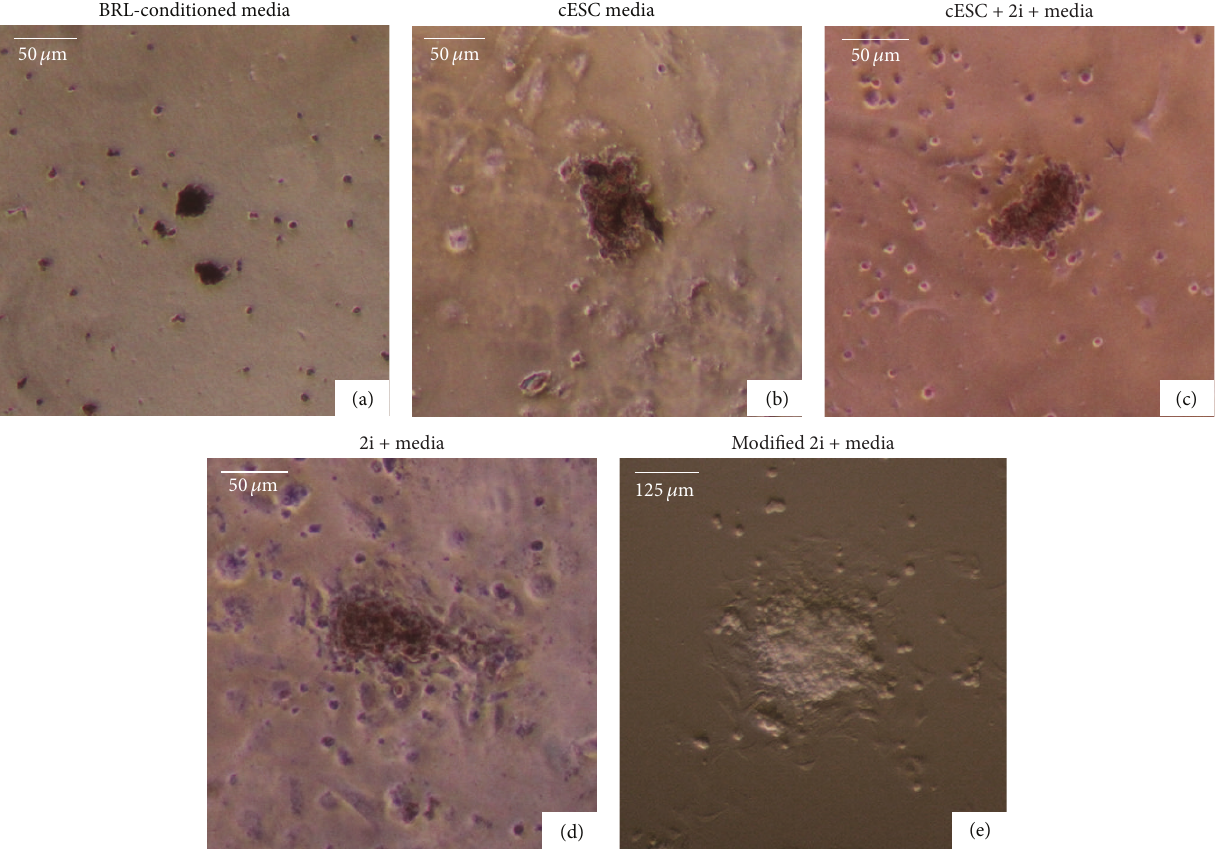
Figure 1: Examples of chicken iPSC-like cells grown in different media conditions during 2nd passage growth. (a) Chicken iPSC-like cells grown in BRL-conditioned media. The cells became darker and detached from the bottom of the plate. They did not survive past the 2nd passage. (b) Cells grown in cESC media initially proliferated well but began to detach from the plate after the 2nd passage. They did not survive past the 4th passage. (c) Chicken iPSC-like cells grown in cESC and 2i+ media did not survive past the 4th passage. (d) Chicken iPSC-like cells grown in 2i+ media did not survive past the 6th passage. (e) Chicken iPSC-like cells grown in modified 2i+ media. The colony was much bigger than the colonies grown in the other 3 media conditions, and the scale bar is adjusted